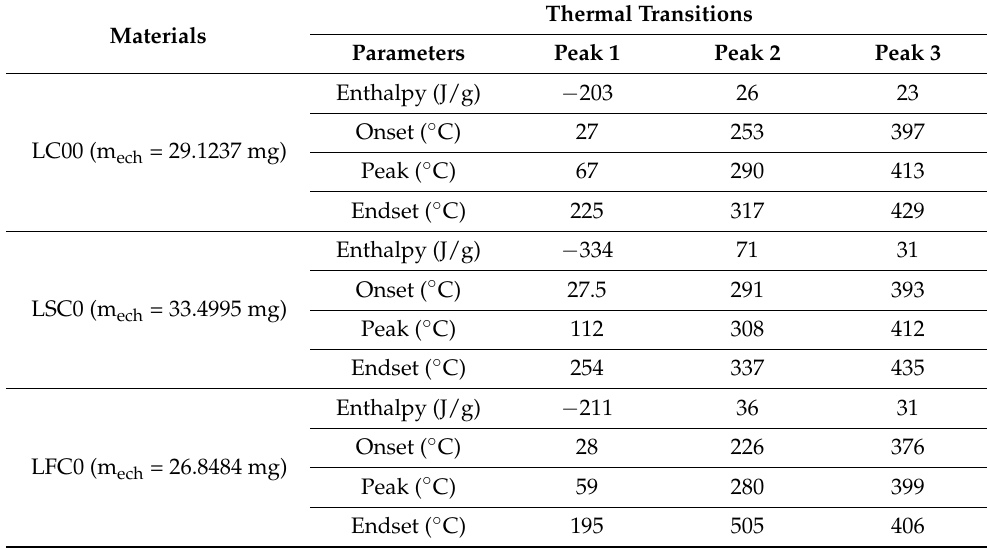
Table 3. Thermal transition parameters of photosensitive 3D-printed composites; m ech refers to the sample